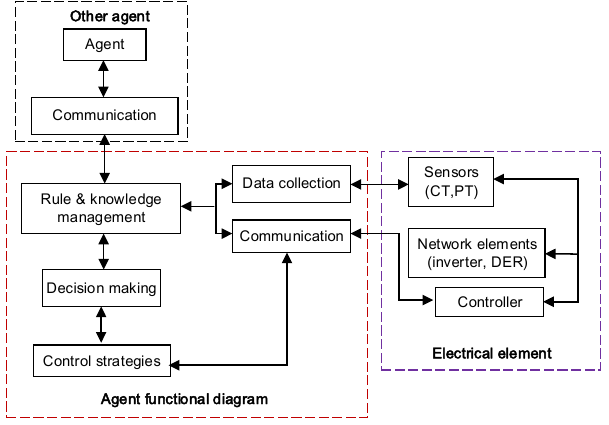
Figure 4. Structure of control agents.